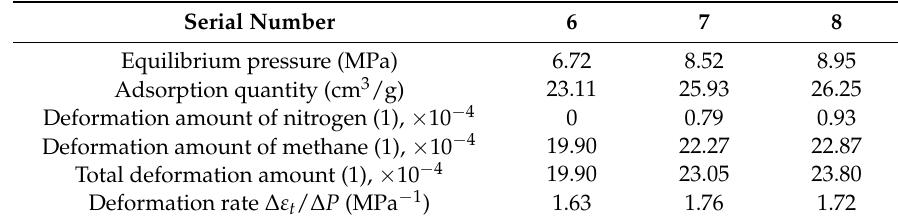
Table 3. The coal matrix deformation amount and deformation rate at the stage where methane is replaced by nitrogen.